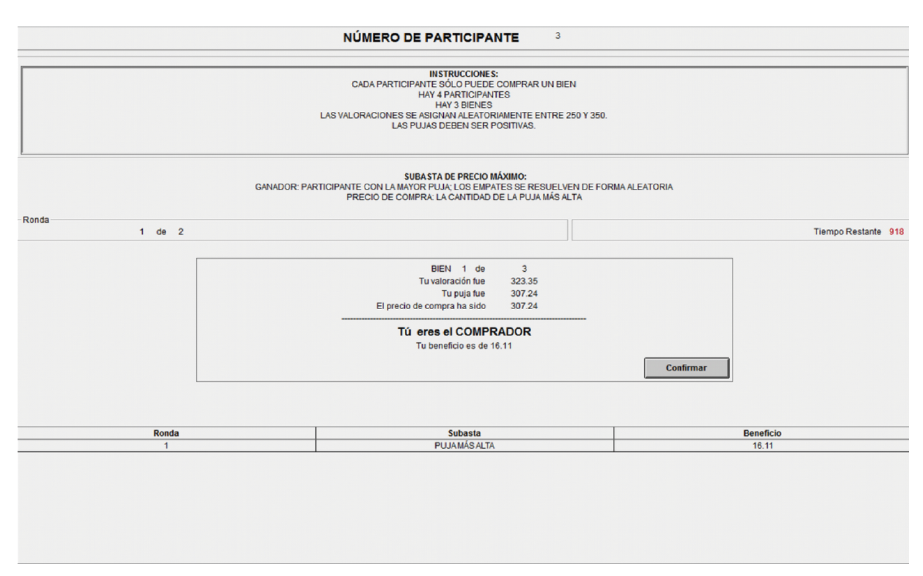
Figure A14. Winner of F